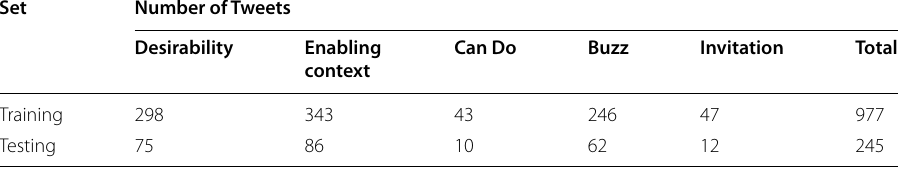
Table 2 Distribution of each class on training and testing set